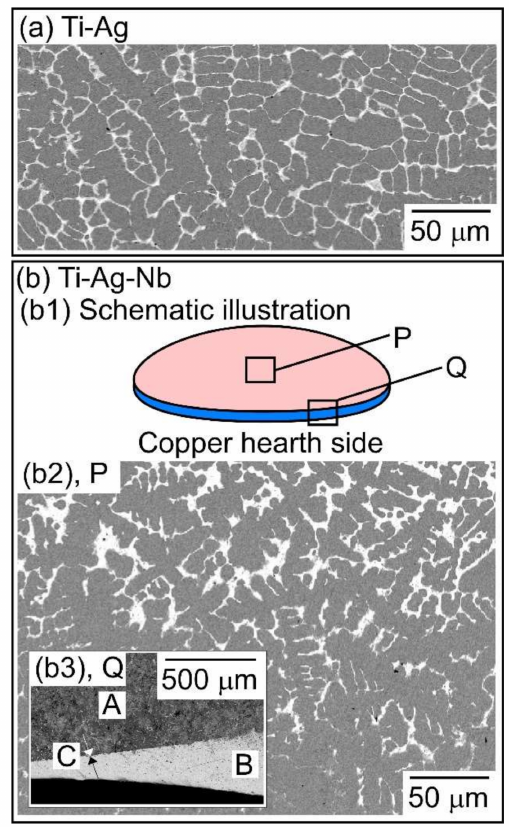
Figure 5. Schematic illustration and SEM-BSE images of the cross-section of arc-melted ingots in the Ti 53.4 Ag 33.3 Nb 13.3 alloy, together with those of the binary Ti 66.7 Ag 33.3 alloy as a reference. (a) Ti 66.7 Ag 33.3 alloy; ( b ) Ti 53.4 Ag 33.3 Nb 13.3 alloy; ( b1 ) Schematic illustration; ( b2 ) SEM-BSE image obtained from the central region indicated by index P in Figure 5b1; ( b3 ) SEM-BSE image obtained from the bottom region indicated by index Q in Figure 5b1. The lower side corresponds to the copper hearth contacted